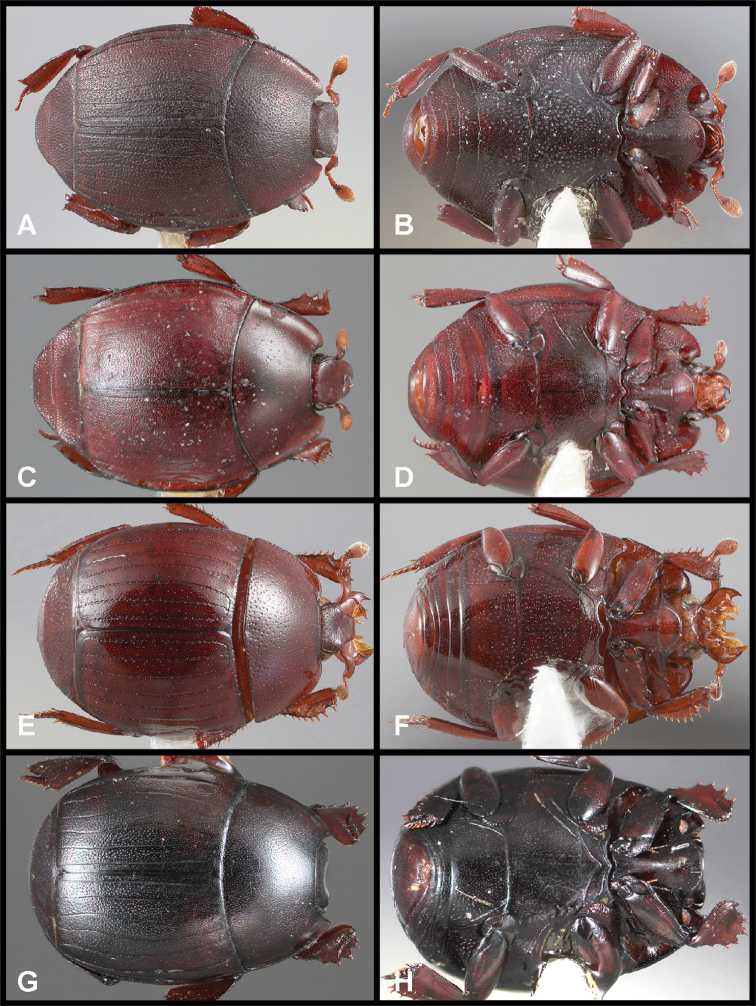
A, BPhelister
genieri: A dorsal habitus B ventral habitus C, DP.
marginatus: C dorsal habitus D ventral habitus E, FP.
vazdemelloi: E dorsal habitus F ventral habitus G, HP.
dilatatus: G dorsal habitus H ventral habitus.